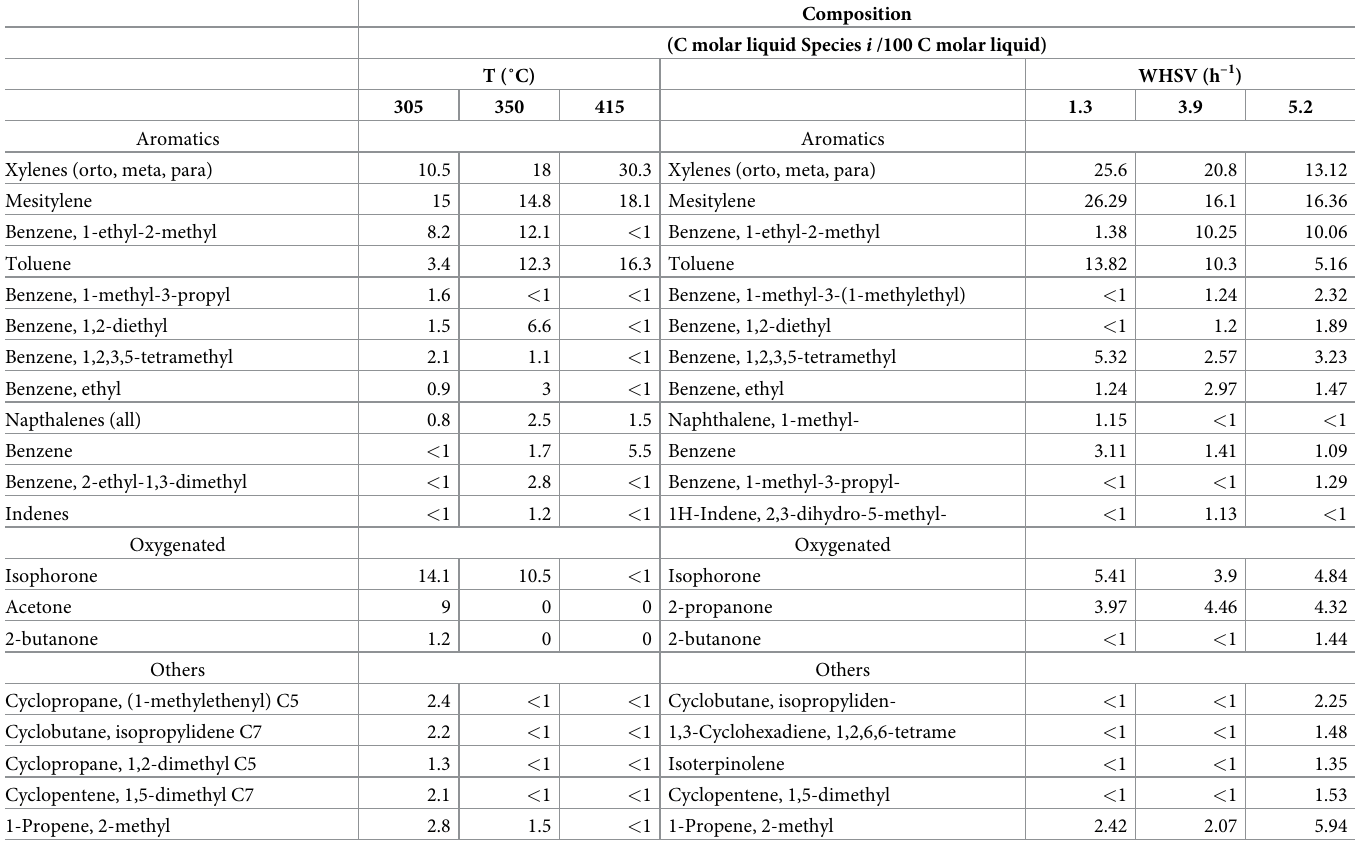
Table 2. Most abundant compound distribution for the acetone reaction over HZSM-5 (80); T = 305, 350, and 415˚C; WHSV = 1.3 h –1 ; and P = 101 kPa (abs) and most abundant compound distribution for the acetone reaction over HZSM-5 (280), T = 415˚C; WHSV = 1.3, 3.9 and 5.2 h –1 ; and P = 790 kPa